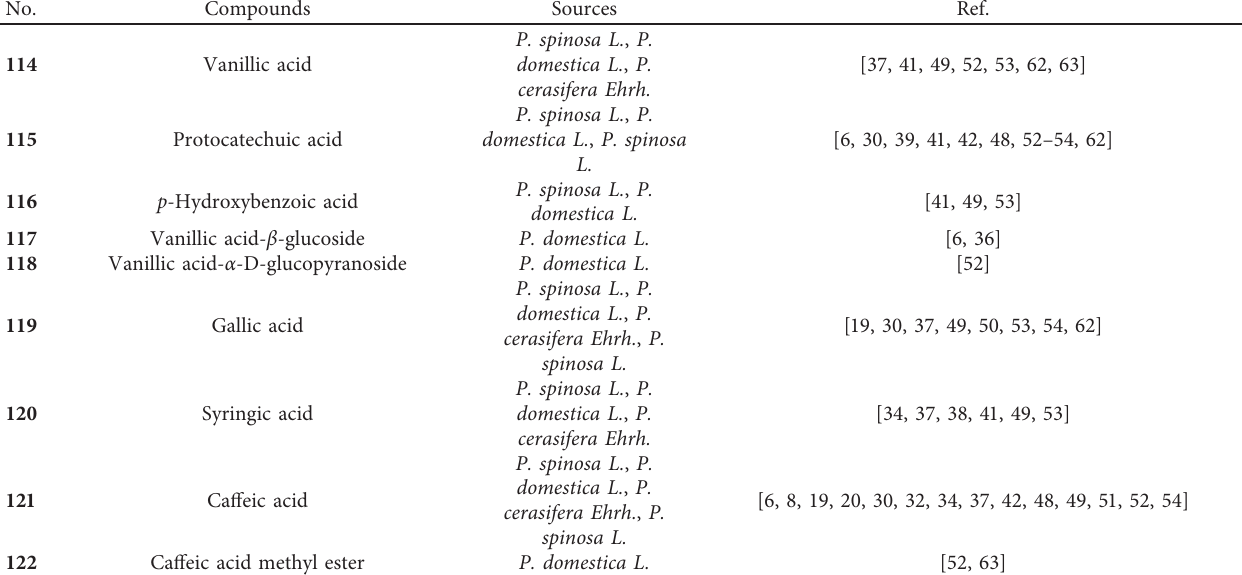
Table 2: Phenolic acids compounds isolated and identified from different Prunus